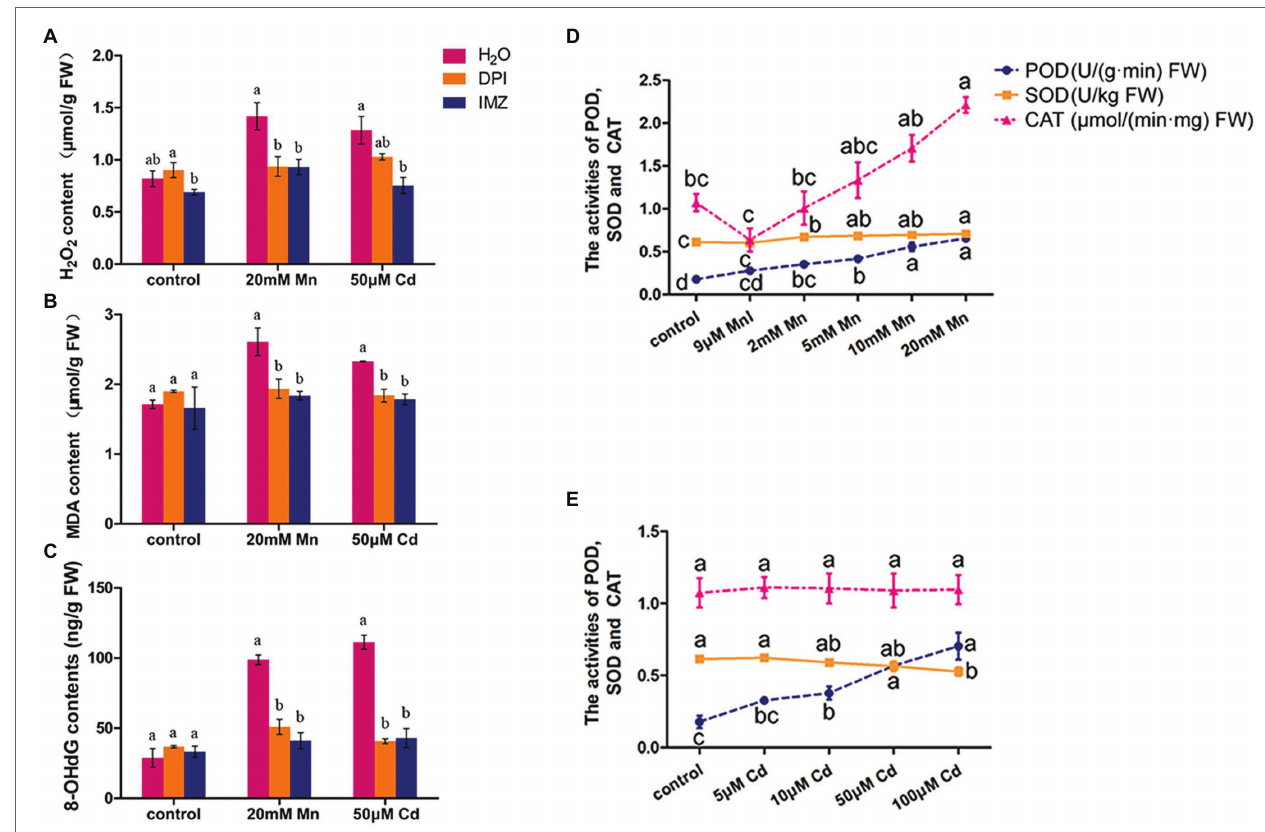
FIGURE 2 | ROS accumulation and scavenging in response to excess Mn and Cd: (A) H 2 O 2 content; (B) MDA content; and (C) 8-OHdG content. DPI, IMZ, and H 2 O refer to samples pretreated with NADPH oxidase inhibitors (DPI and IMZ) or H 2 O prior to heavy metal exposure. (D , E) The activities of POD, SOD, and CAT in leaves with Mn (D) and Cd (E) treatments. Data represent mean ± SD of six biological replicates per treatment. Letter annotations indicate significant differences according to Duncan’s multiple range test ( p <